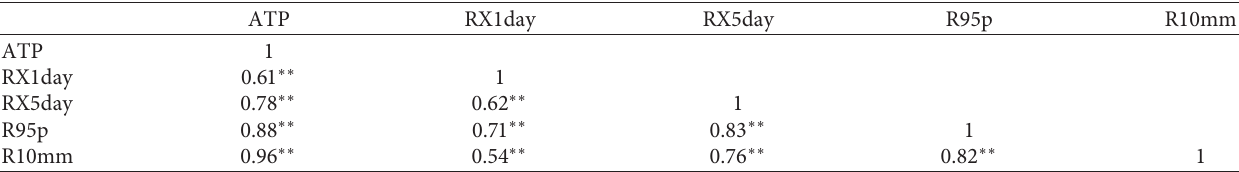
Table 3: Pearson correlation coefficients between annual total precipitation and extreme precipitation indices and cross-correlation coefficients between different extreme precipitation